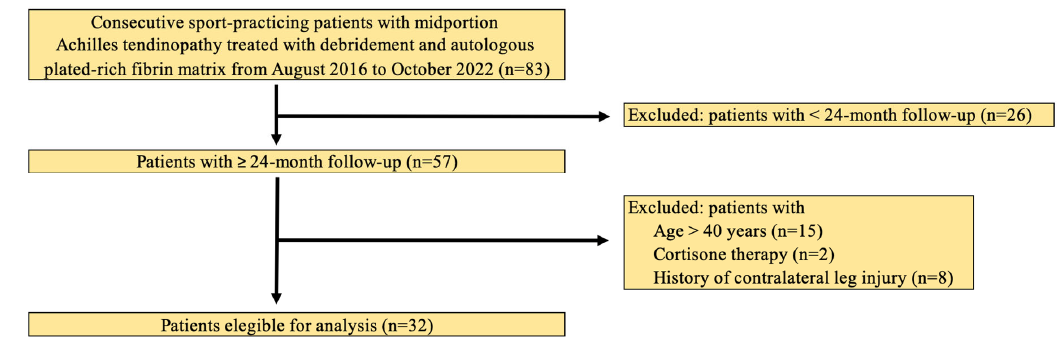
Figure 2. Patient eligibility.